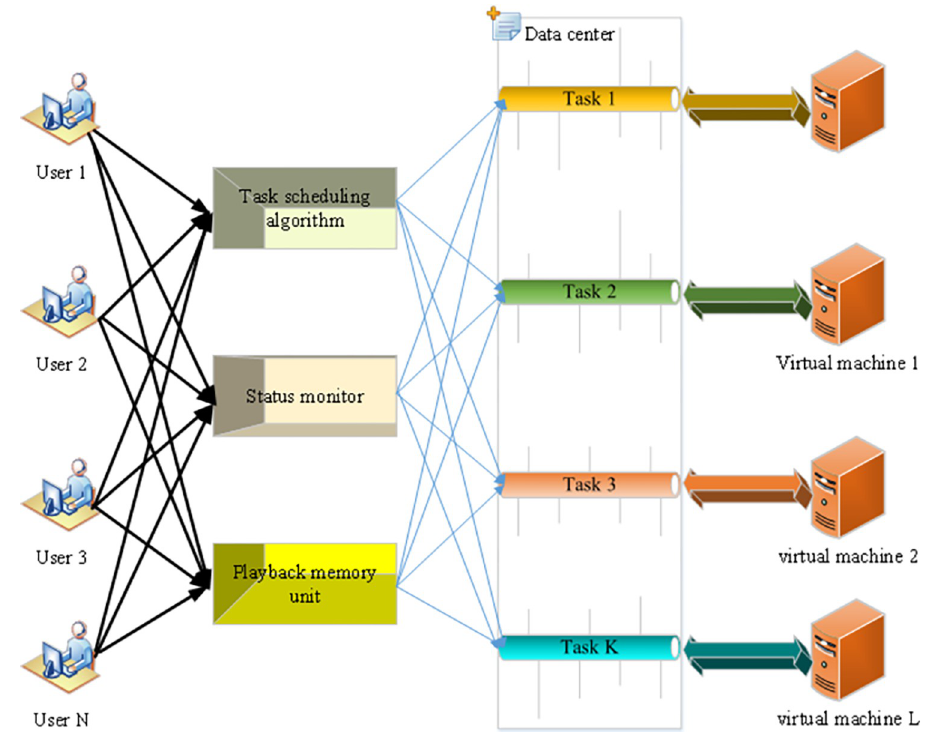
Fig 5. Task scheduling principle of the cloud data